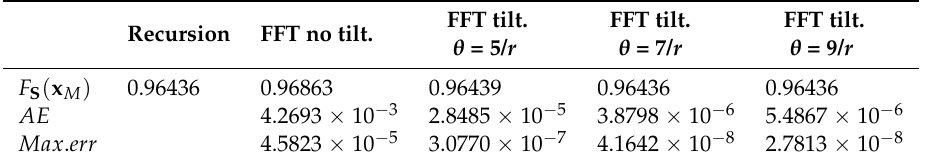
Table 4. Example 2: Comparing recursive and FFT methods for h = 1, r = 64 and various θ .